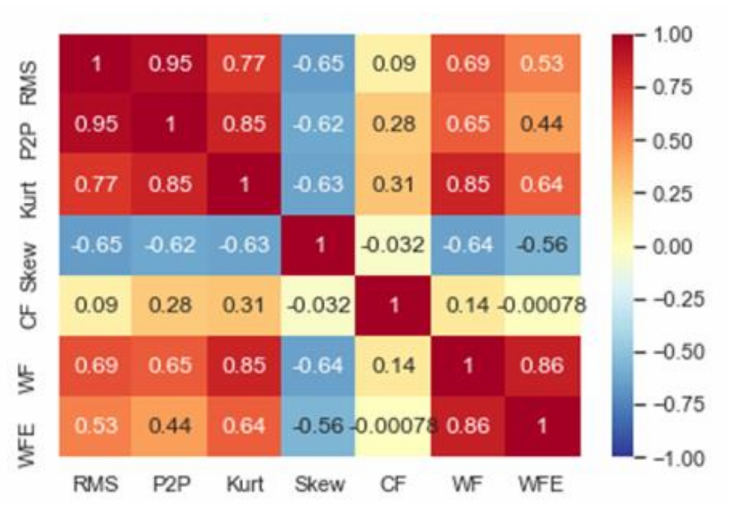
Figure 9. Correlation matrix of features for